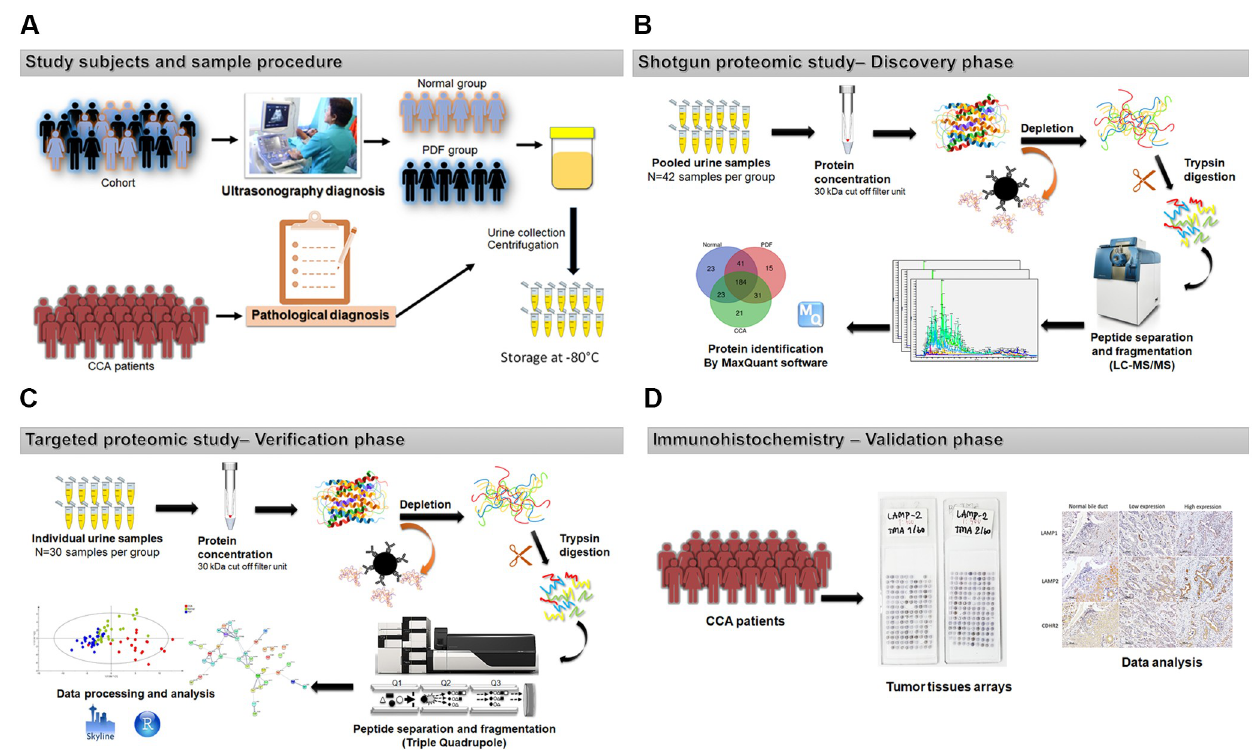
Fig 1. The workflow for urinary protein biomarker discovery. (A) urine samples were collected from participants and stored at -8000b0c until analysis. (B) urine samples selected for study were pooled, concentrated and depleted for highly-abundant protein removal using an immunodepletion kit, followed by in- solution tryptic digestion and tandem mass spectrometry. Protein identification and database searching were conducted using MaxQuant software (version 1.6.1.0). (C) Biomarker qualification for selected candidates used a custom MRM-MS assay. Data processing was performed using the Skyline and R programs. The statistical analysis software “SIMCA” and “SPSS" were used to perform the univariate/multivariate statistical analysis. (D) Immunohistochemical staining techniques were used to validate potential biomarkers on